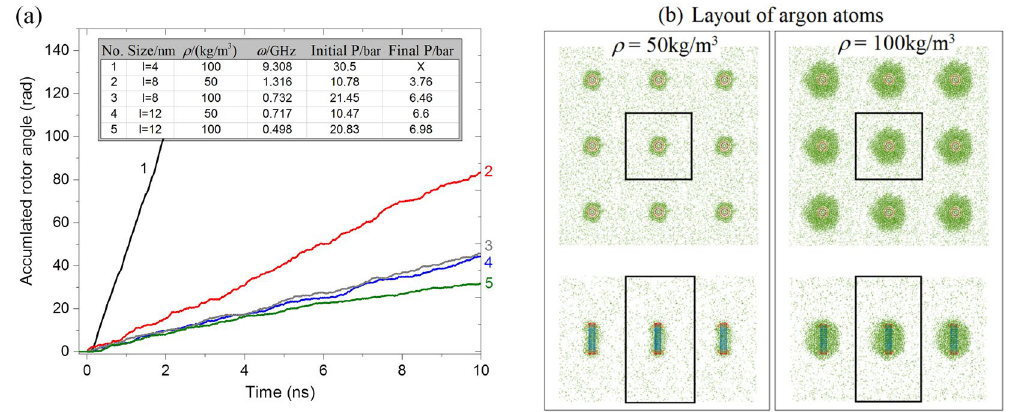
Figure 10. Comparison of MD results. ( a ) Histories of the accumulated angle of rotor in different boxes with different argon density. The related rotational frequency of the rotor and pressure (P) of the box are in the inserted table. The “size” in the inserted table is the width of the box. The nanomotor with N = 2 is used. ( b ) Layout of the argon atoms in the box with l = 12 and the rotor in stable